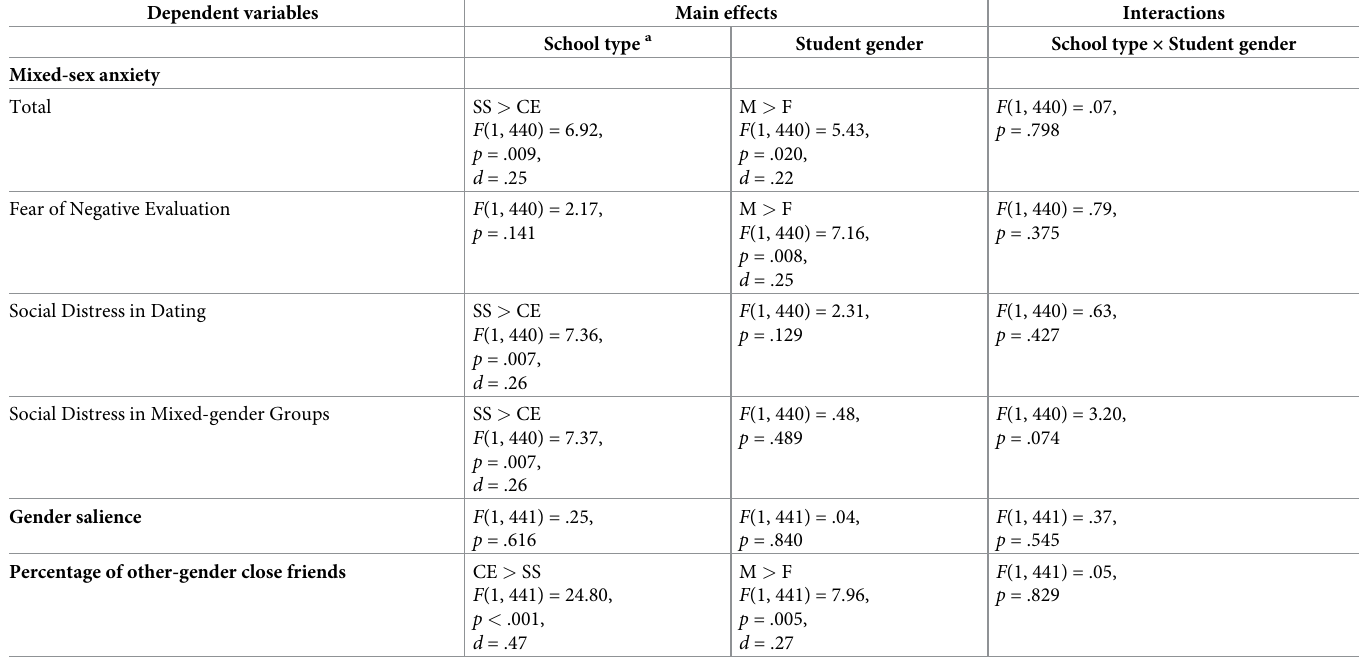
Table 7. 2 × 2 (School type × Student gender) ANCOVA results (Study 2: College sample).